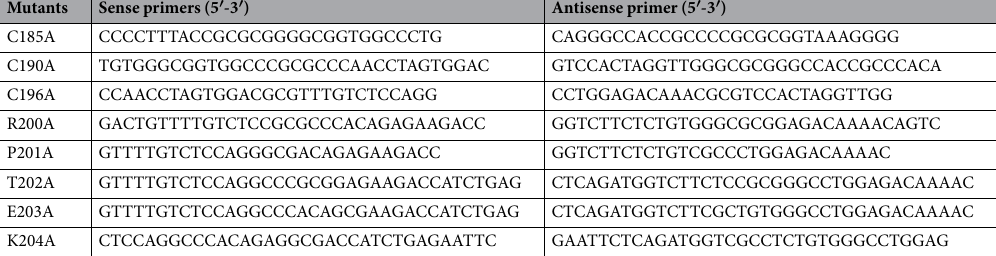
Table 3. The primers used for site-directed mutagenesis